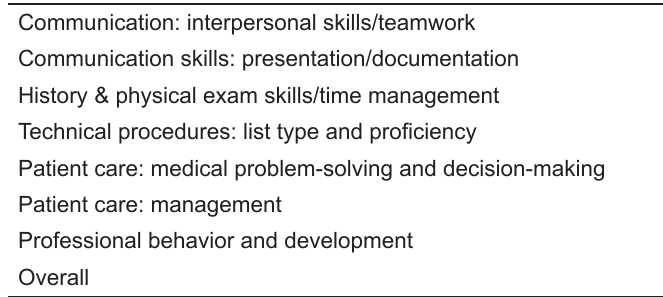
Table 1. End-of-shift assessment